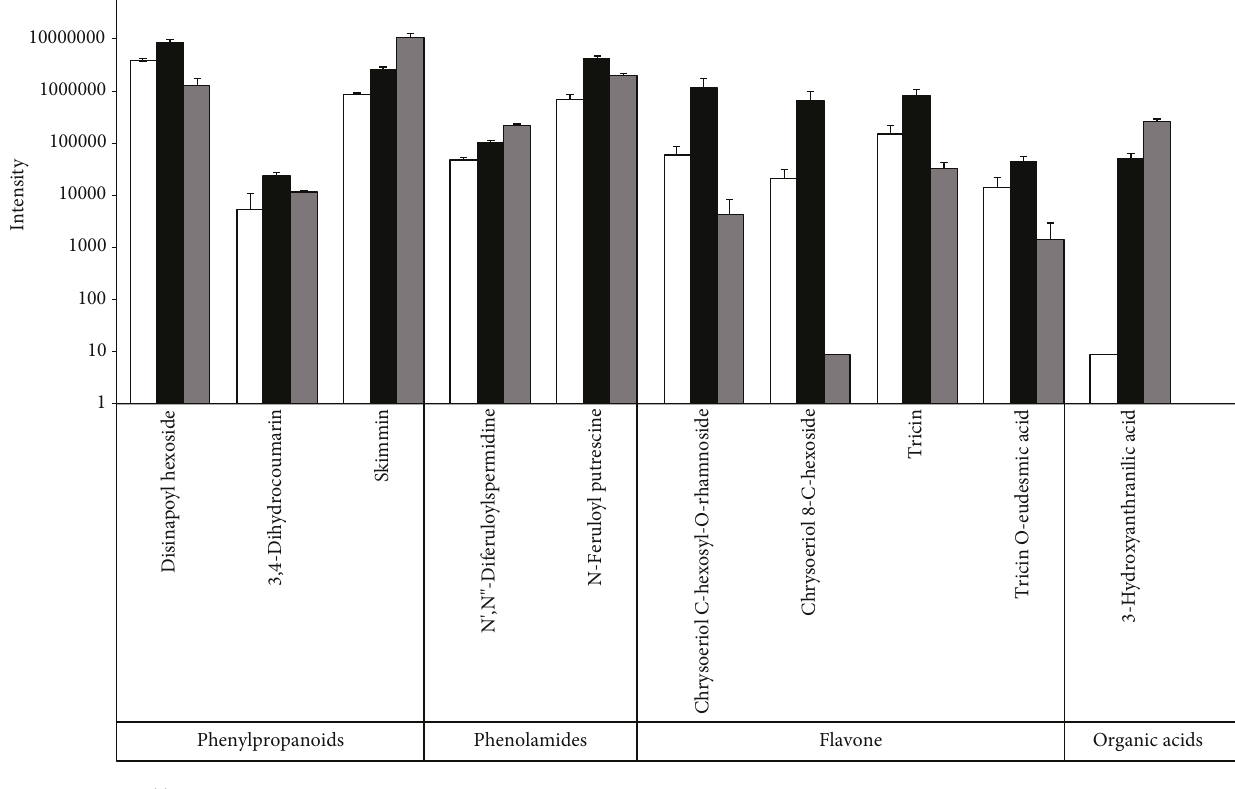
Figure 5: Ten signi fi cantly changed metabolites among all cultivars in the sweet corn ’ s